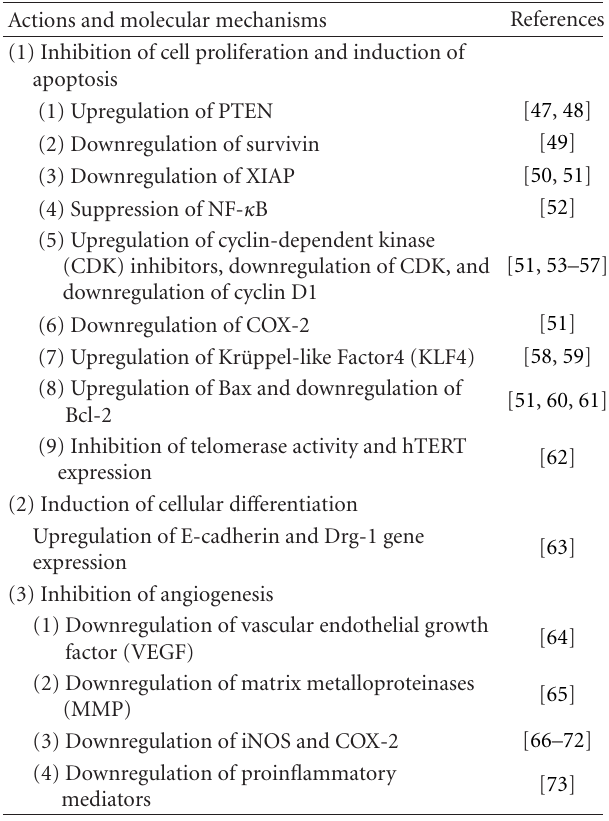
Table 1: Potential molecular mechanisms for anticancer activity of PPAR γ